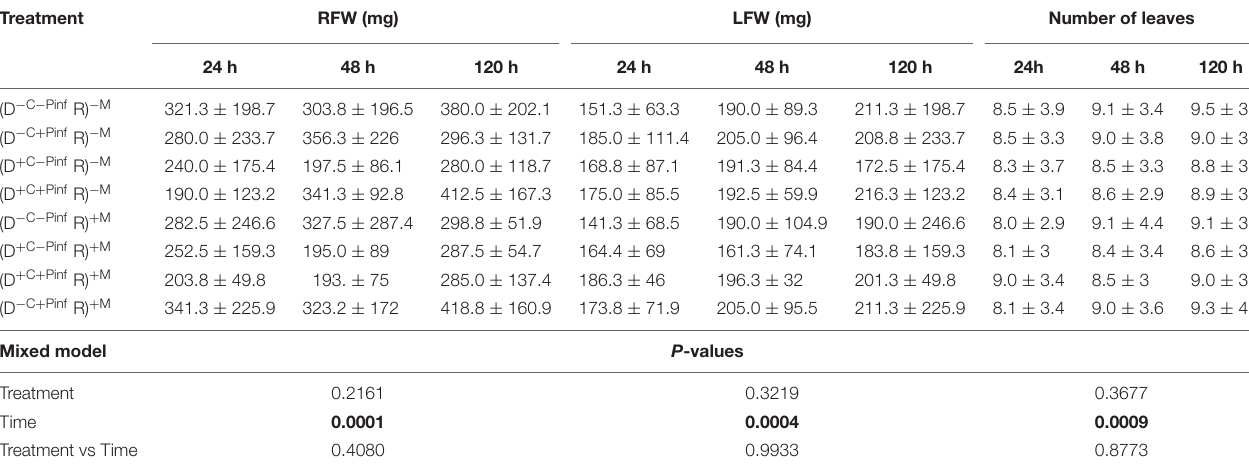
TABLE 3 | Root fresh weight (RFW), leaf fresh weight (LFW), and number of leaves of the receiver potato plantlets—R (i.e., plantlets grown in the HC) connected to the donor potato plantlets—D (i.e., plantlets grown in the RC) via the extraradical mycelium of R. irregularis MUCL 41833.